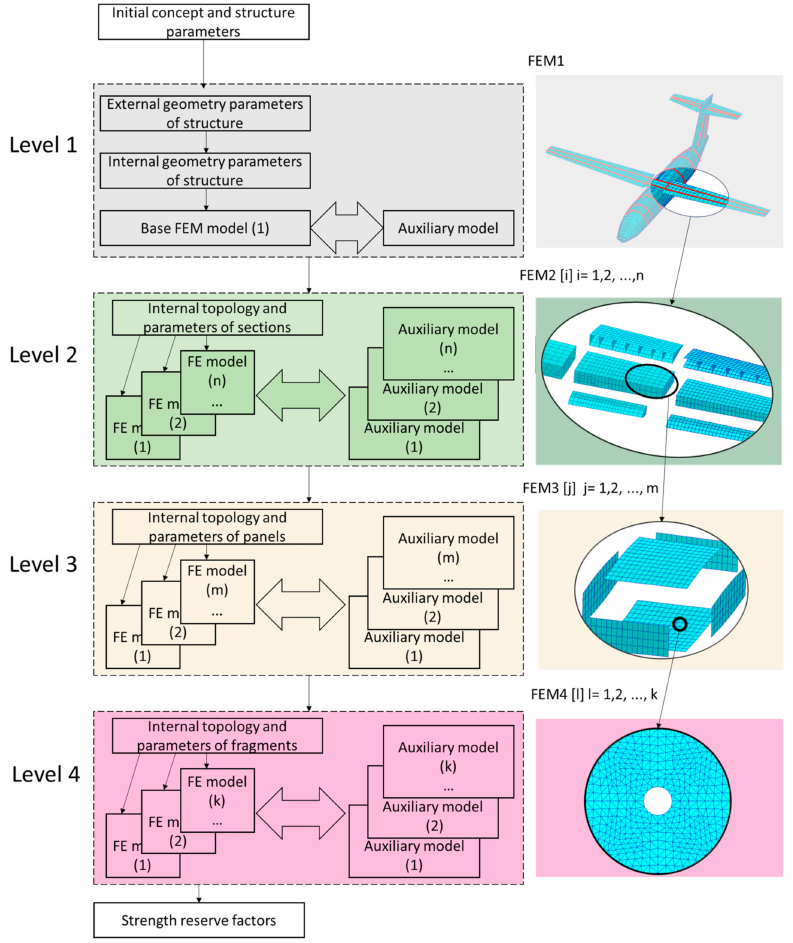
Figure 3. Block scheme of the four-level airframe strength models decomposition in strength